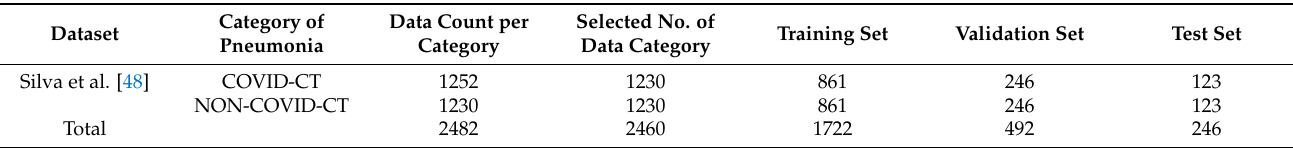
Table 2. Description of the computed tomography (CT) dataset showing COVID-19 and non-COVID-19 categories including the distribution of images per category as well as the num- ber of selected images per category.